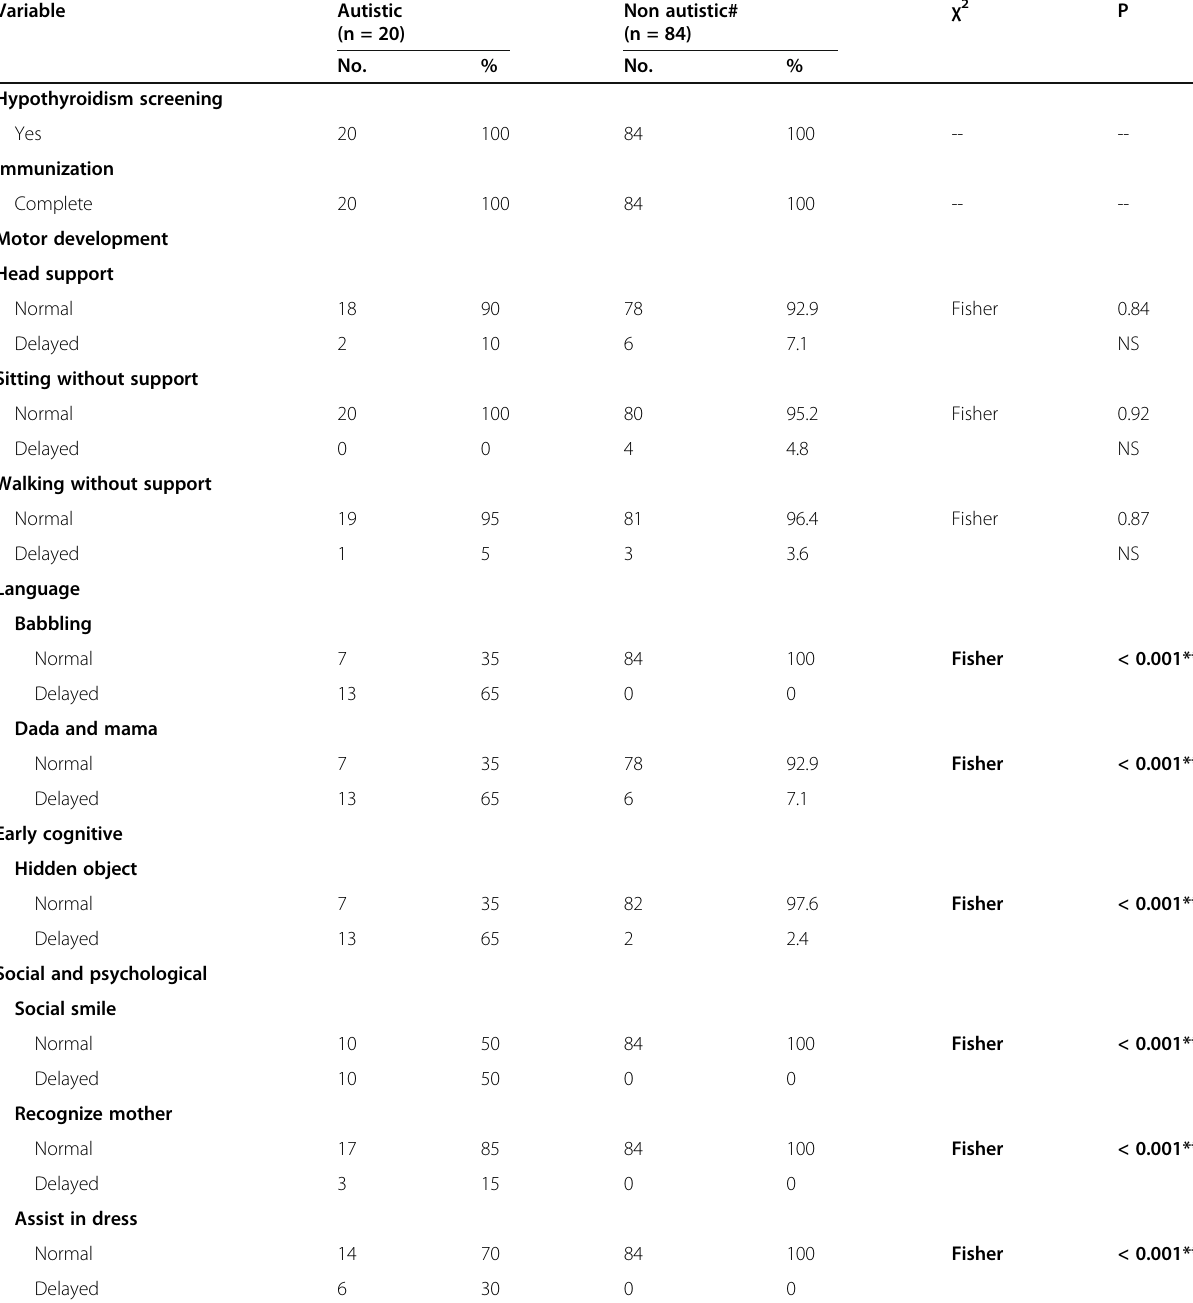
Table 6 Comparison between autistic and non-autistic children in immunization and developmental history